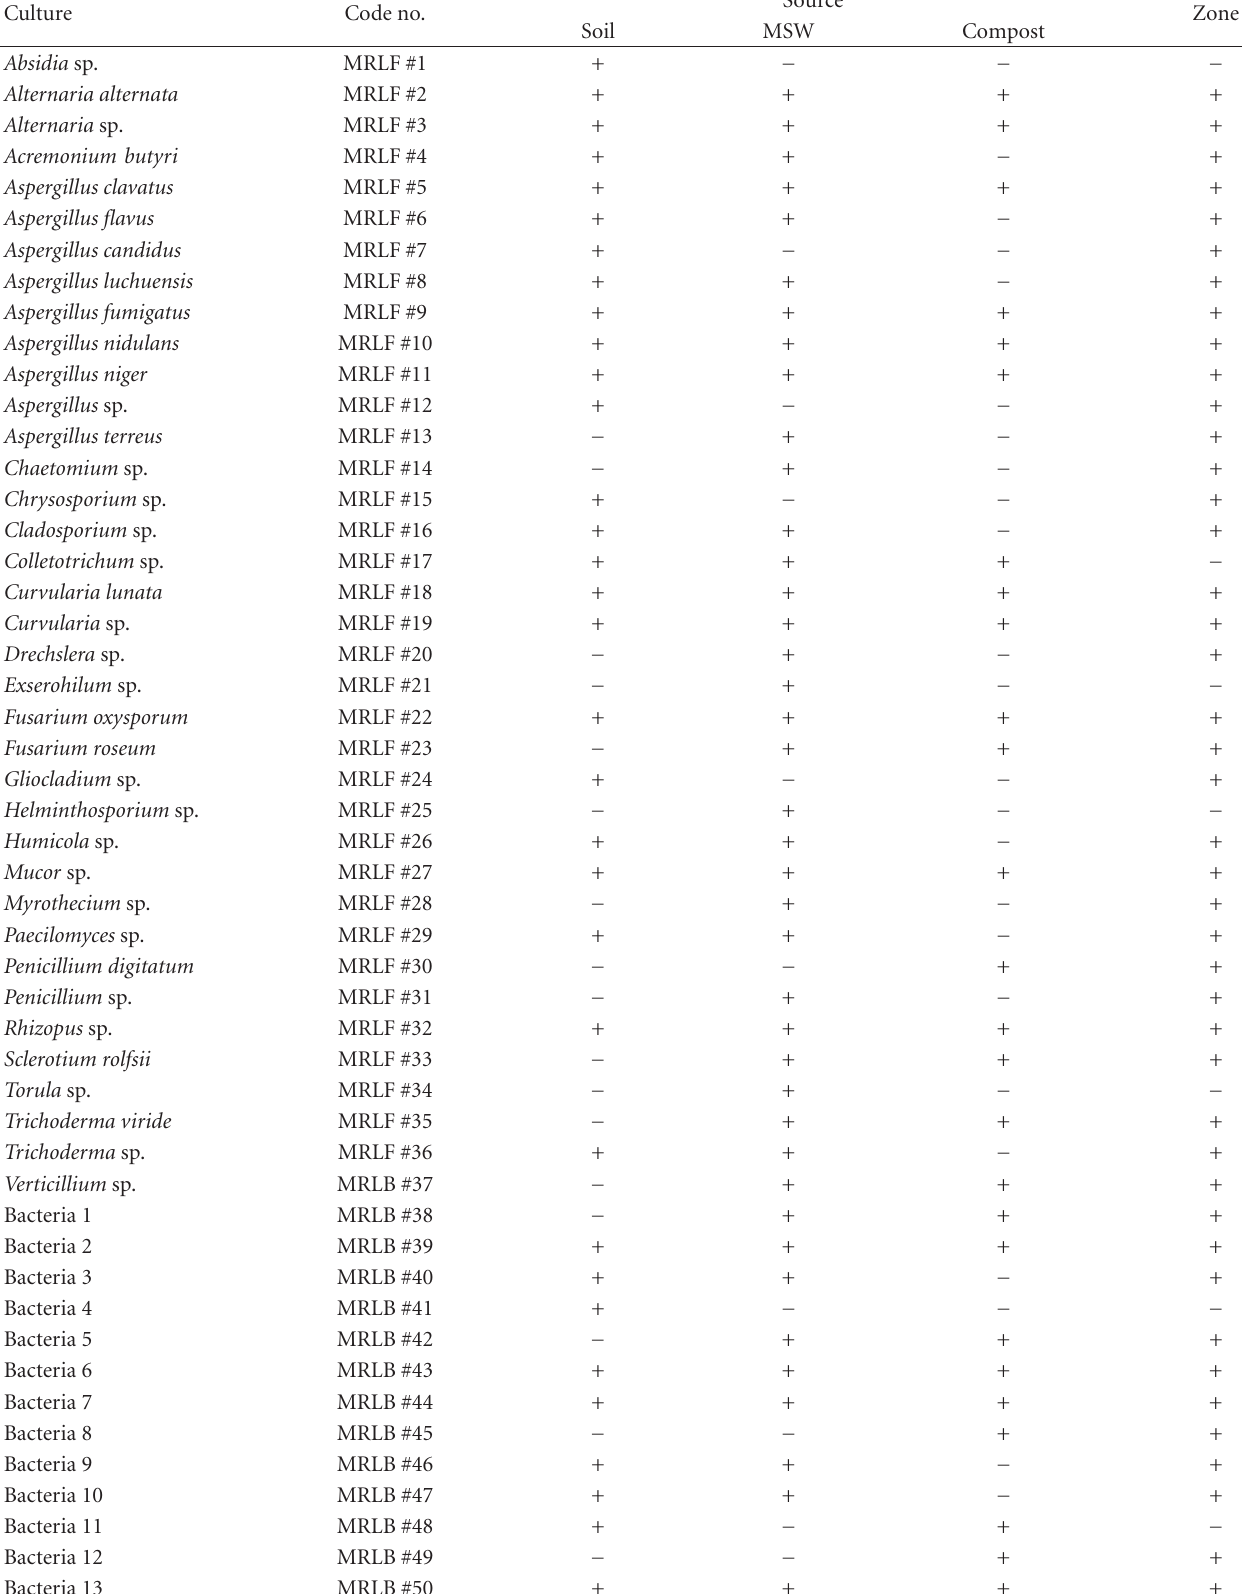
Table 1: Preliminary screening of cellulose-degrading microbes isolated from di ff erent sources.